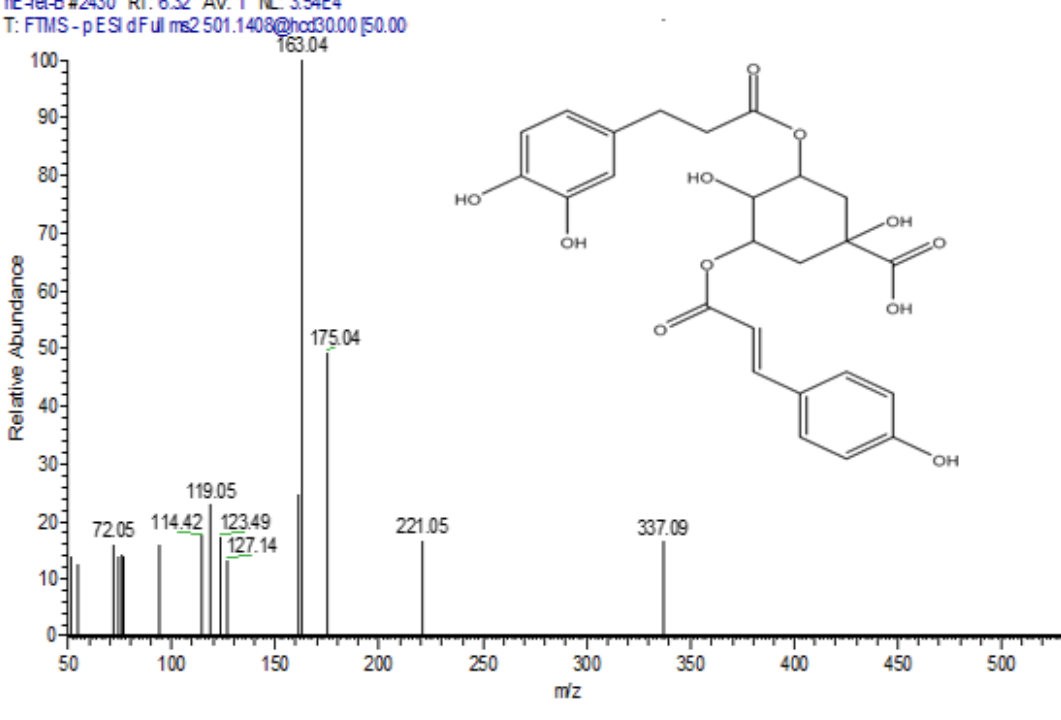
Figure 2. LC/MS/MS chromatogram of dihydrocaffeoyl coumaroyl quinic acid.